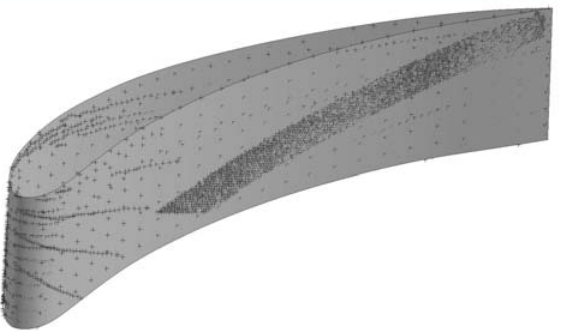
Fig 6. Point cloud of wing section surface obtained by scanning tacheometer with 3D surface created